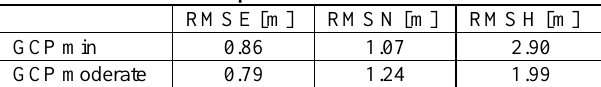
Table 8: RMS at check points